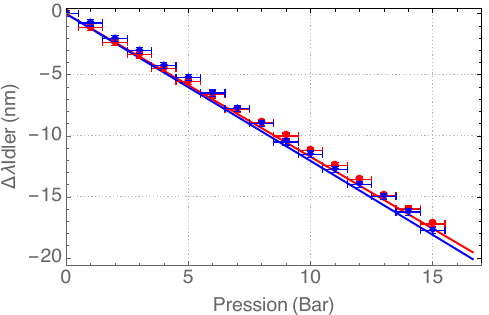
Fig. 3. Plot of peak shift as function of pressure for two nanofibers and the corresponding theoretical calculation with known parameters of the experiments. Red Symbols and line, nanofiber diameter 853nm, pump à 887nm. Blue Symbols and line, nanofiber diameter 867nm, pump at 916.5nm.